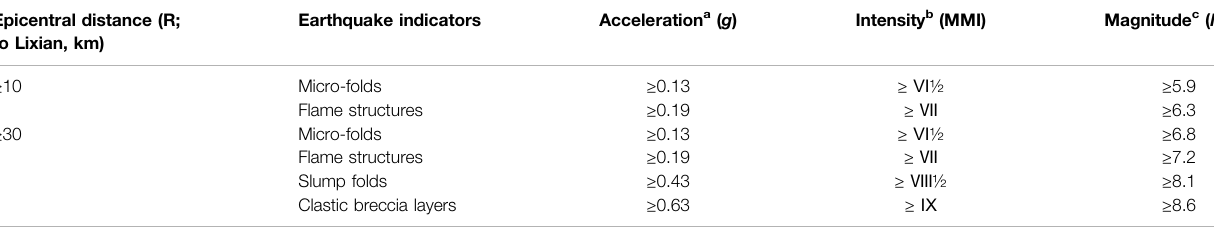
a Data are obtained from Supplementary Figure S4C . b Based on MMI, 3.311 log PGA, 0.354 (Du et al., 2019).